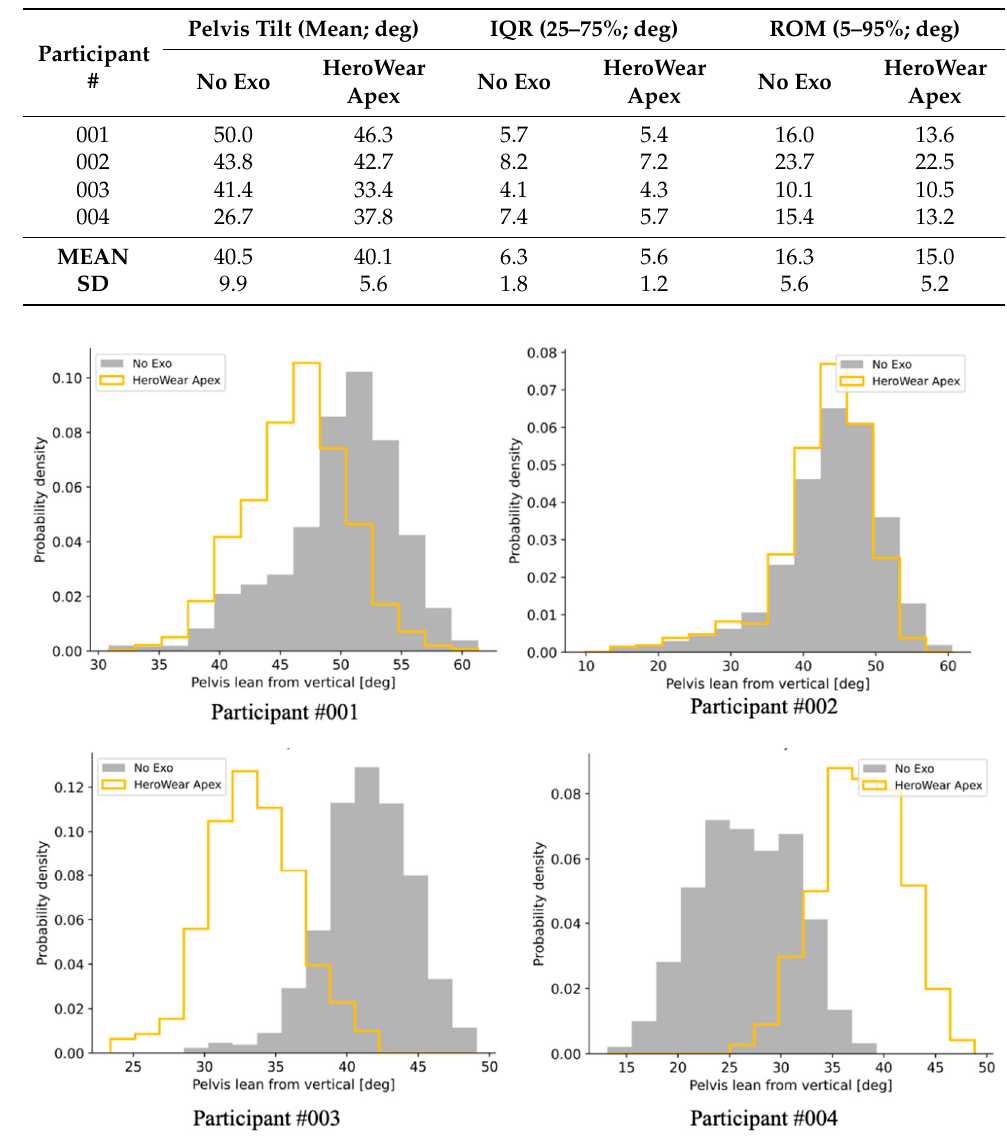
Figure 5. Histograms of pelvis lean from vertical for pushing the loaded gondola uphill. Table 3 and Figure 6 illustrate the effects of the HeroWear Apex on the pelvis tilt angles of the participants when pushing the unloaded gondola downhill. During the downhill pushing of the gondolas, the participants showed reduced forward pelvis tilt with the HeroWear Apex again. Participant #003 even leaned to negative angles (leaning back). The basic mechanics of lowering a heavy gondola downhill require the body to lean back more, but the additional backward angle with the HeroWear Apex suggests that it may “pull” the hip into